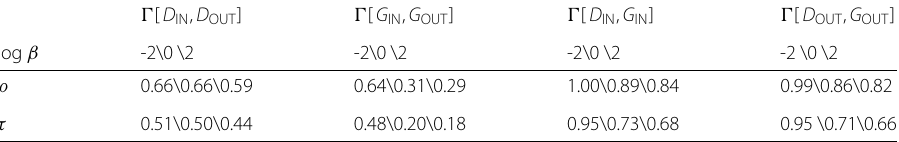
Table 3 Correlation coefficients (cid:7) [ X , Y ] between variables X , Y ∈ { D IN , D OUT , G IN , G OUT